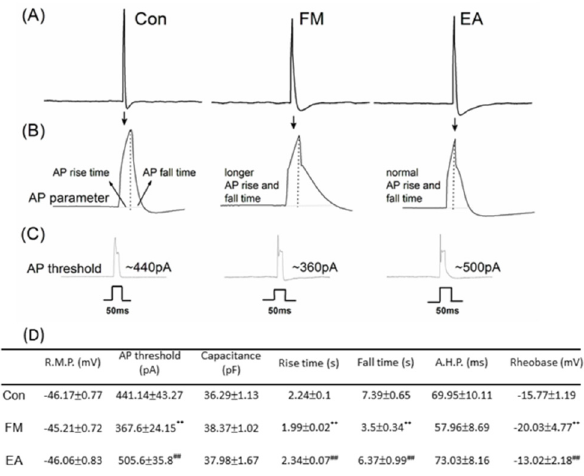
Fig 2. Electrophysiological properties of L3-5 dorsal root ganglion (DRG) neurons from Con, FM, and EA groups. (A) The action potential (AP) threshold was lower in the FM group than the control group. EA reduced neuronal excitation by increasing AP threshold, reversing the effect of acid injection. (B) FM induction decreased both AP rise and fall times compared to controls, effects also reversed by AE. (C) There were no significant group differences in AP amplitude and afterhyperpolarization (AHP) duration. (D) Data summary and statistical